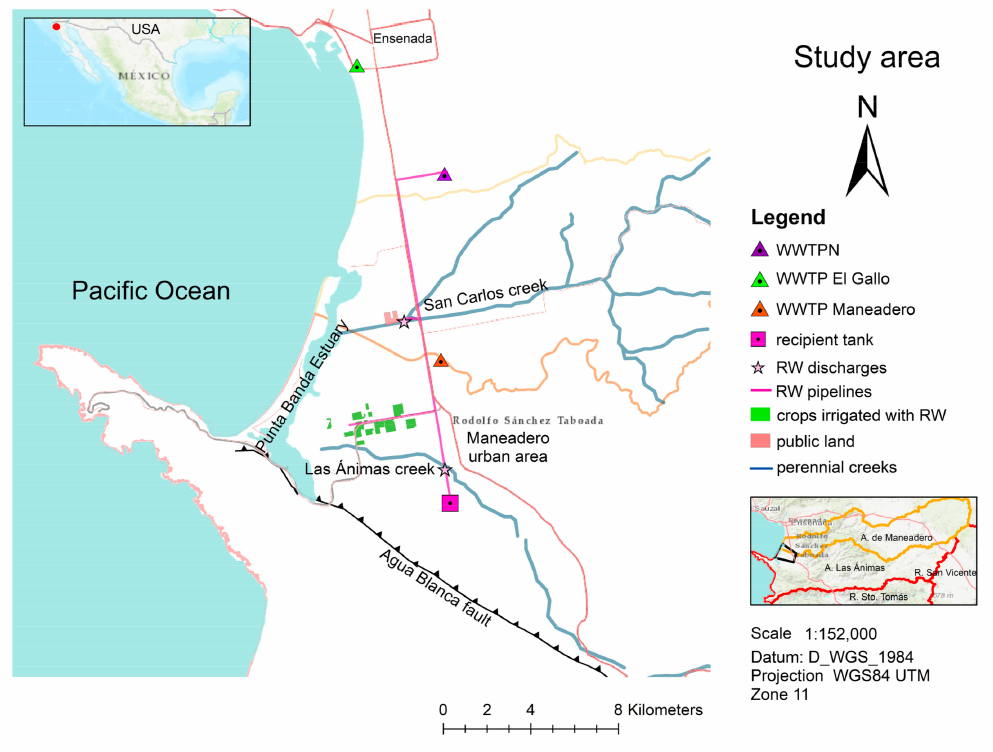
Figure 1. Location of the reclaimed water (RW) discharges sites and ponds for RW storage for agricultural irrigation in the Maneadero